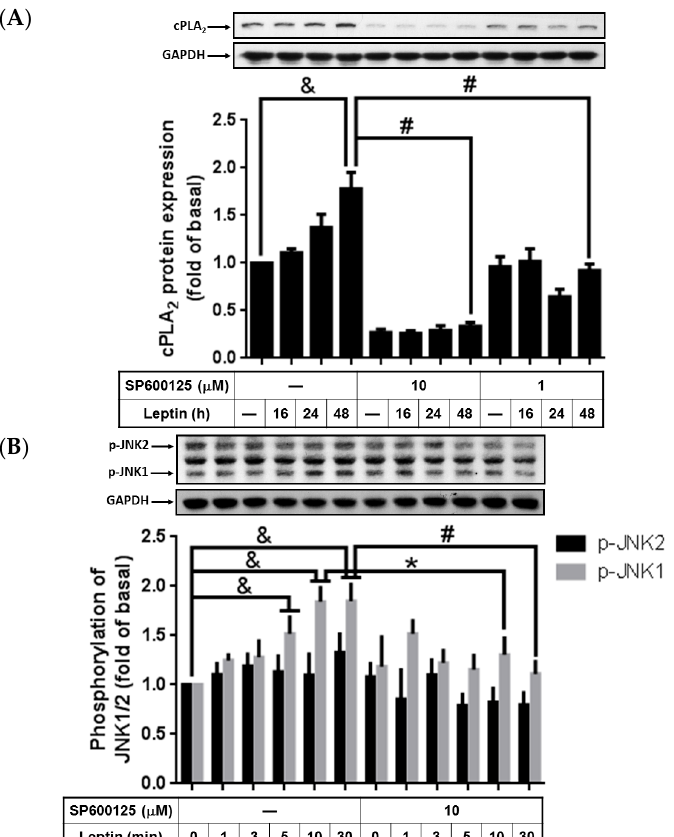
Figure 4. Leptin-mediated cPLA 2 - α expression and JNK1/2 phosphorylation were inhibited by SP600125. Serum-starved A549 cells were pretreated with different concentrations of SP600125 for